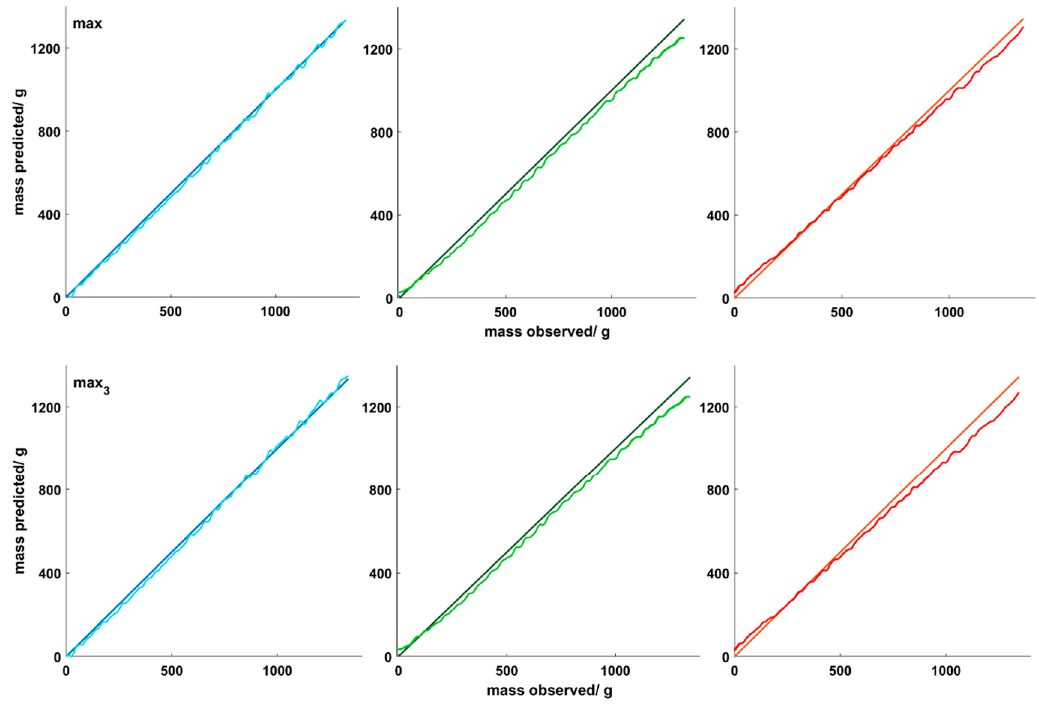
Figure 4. Observed versus predicted coating masses of (blue) ASA, (yellow) placebo and (red) diclofenac cores using the two different normalization methods.